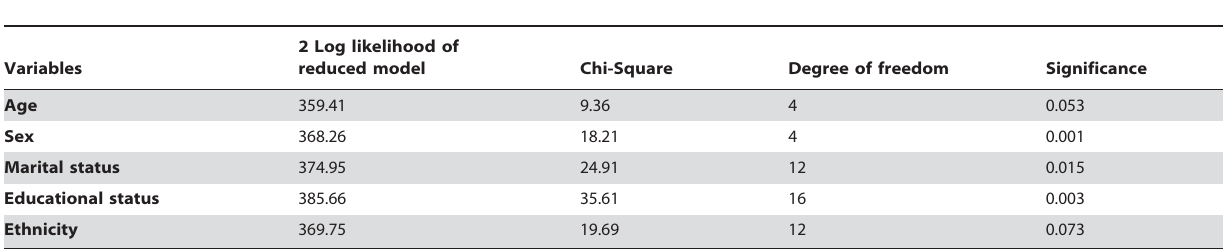
Table 4. Multiple logistic regression analysis model for socio-demographic characteristics against CPI